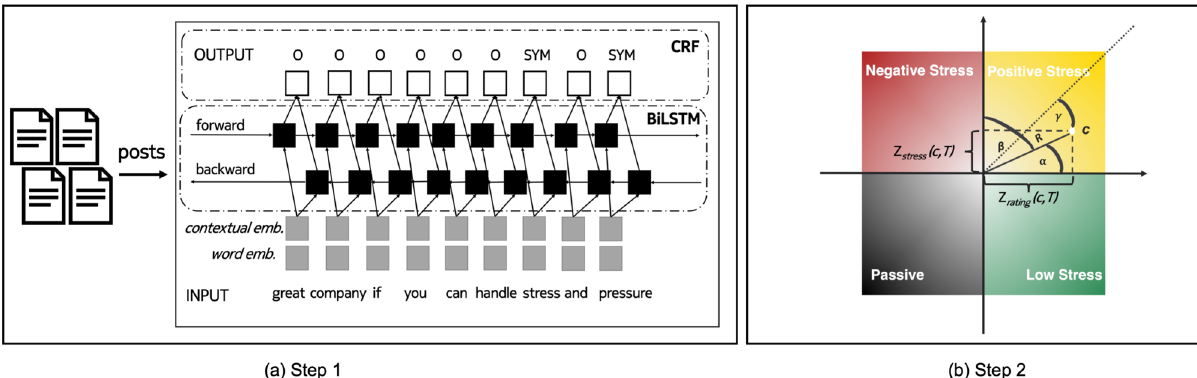
Figure 1. Placing companies on a stress-by-rating quadrant by detecting stress mentions in reviews about a company using a state-of-the-art NLP deep-learning framework ( Step 1 ), placing the company in the rating-by- stress quadrant, and computing its association with its stress type (i.e., with its quadrant) ( Step 2 ). To see how the association is computed, consider company c shown in (b) to be of positive stress. c is placed according to its z rating ( c , T ) along the x -axis, and to its z stress ( c , T ) along the y -axis. R is the radius from the center to c ’s point; α is the angle between the radius line and the x -axis; β is the angle between the radius line and the y -axis; and γ is the angle between the radius line and the diagonal shown as a dotted line. The function f ( c , s , T ) combines R , α , β , and γ , and accordingly scores c to have a high association weight with positive stress s during period T (darker shades of colors), as c is close to the quadrant’s diagonal, and distant from the intersection